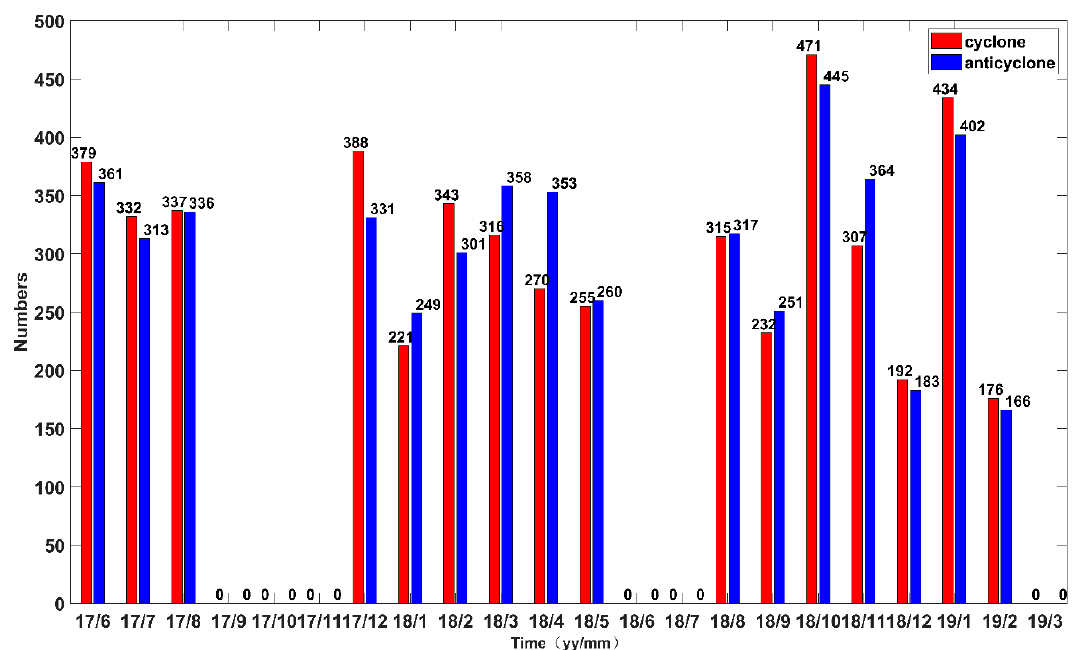
Figure 9. Histogram of the monthly distribution of eddies identified by CI-derived gradient parameters.